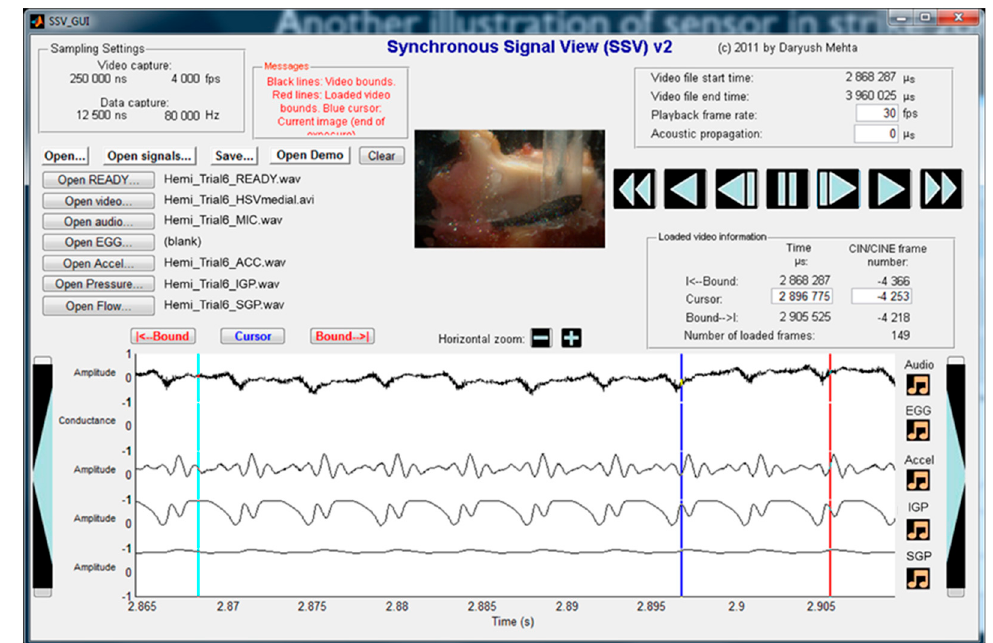
Figure 7. Custom graphical user interface for the playback of high-speed video data and synchronously recorded sensor signals. See Supplemental Video S2 for multimedia playback.